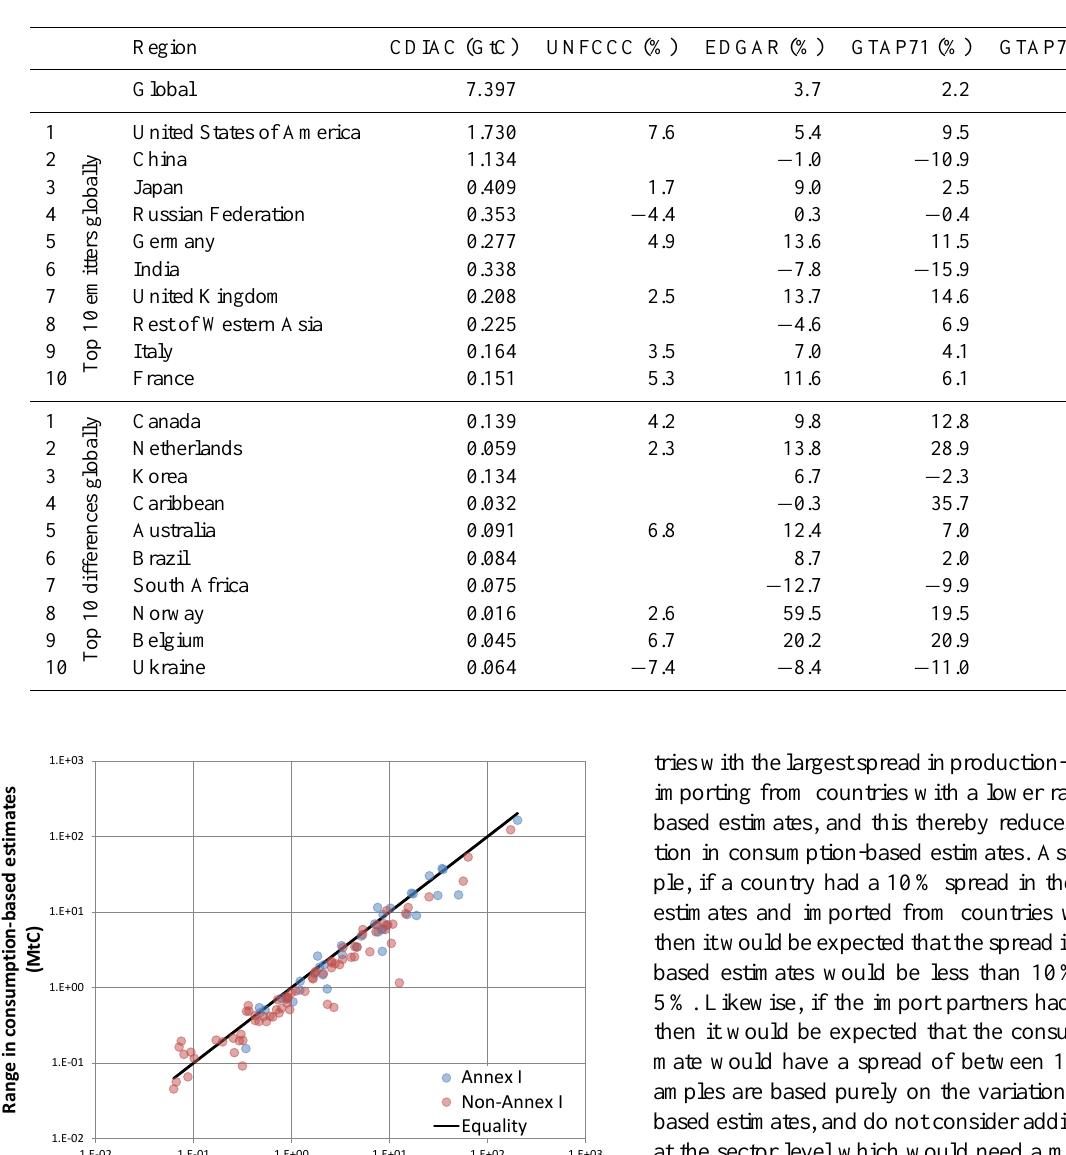
Table 5. Estimates of consumption-based inventories (2004) using the emissions data from Table 2 (see caption and text). The first column shows the total emissions from CDIAC, and the other columns are percentage comparisons with CDIAC (positive is greater than CDIAC). The percentage differences are around the same order as for production, suggesting that the dataset used for the production-based emissions is important in determining the variation in consumption-based emissions between studies. The “Top 10 differences globally” are sorted by the range in estimates; maximum minus minimum.